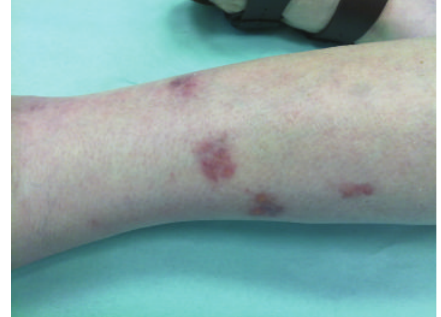
Figure 1: Multiple violet skin lesions in the right lower extremity of the patient. Pitting edema of the ankle and foot is also demonstra- ted. The inlet depicts one of the lesions, where an orifice leading to a pus collection is shown.